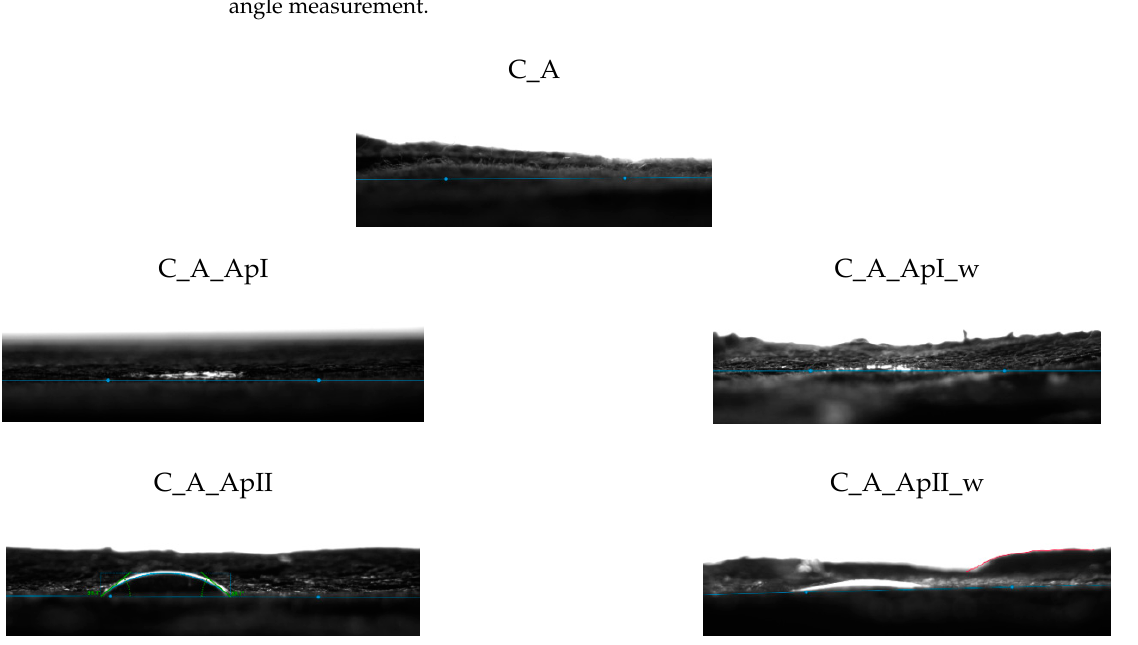
Figure 11. Photographs of a water drop on the satin weave fabric samples during contact angle measurement.